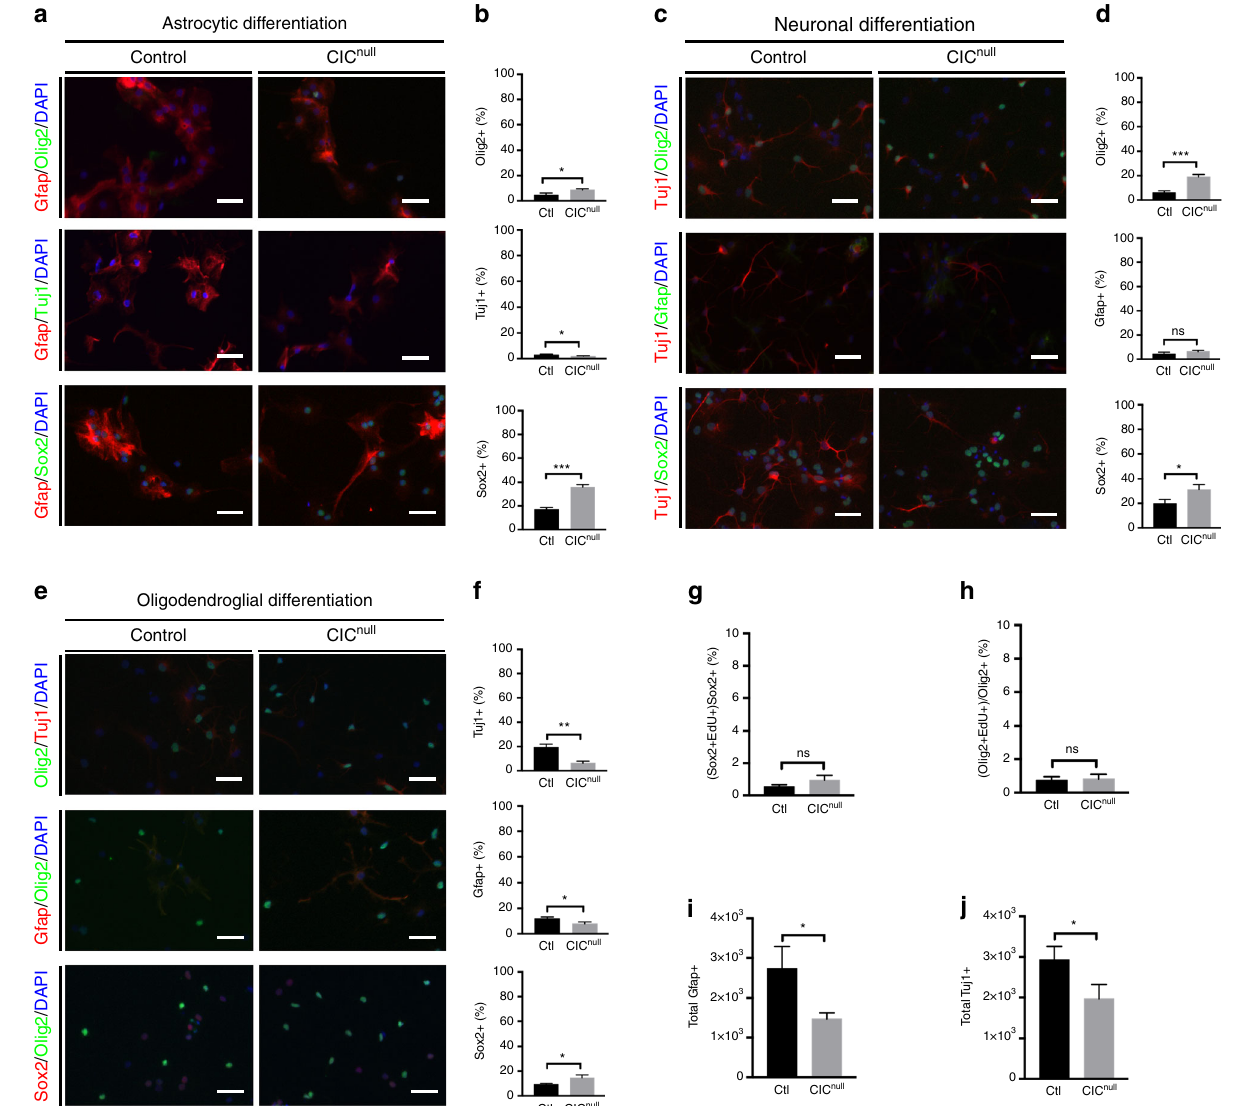
Fig. 6 Alternate lineage selection of Cic -null NSCs in response to extrinsic differentiation cues. a , b NSCs cultured for 10 days in astrocyte-promoting media and stained for Sox2, Olig2, GFAP, and Tuj1. Representative images of cultures stained for oligodendrocytes (Olig2 + ), neurons (Tuj1 + ) and stem cells (Sox2 + ) in a ; and corresponding quanti fi cations of Olig2 + cells, Tuj1 + cells, and Sox2 + cells as a percentage of total cell enumerated by DAPI nuclear counterstain b . c , d NSCs cultured for 10 days under neuronal-promoting conditions, with representative images c of cultures stained for oligodendrocytes (Olig2 + ), astrocytes (Gfap + ) and stem cells (Sox2 + ), and corresponding quanti fi cations d of Olig2 + cells, Gfap + cells, and Sox2 + cells as a percentage of total cells enumerated by DAPI. e , f NSCs cultured for 10 days under oligodendroglial-promoting conditions, with representative images e of cultures stained for neurons (Tuj1 + ), astrocytes (Gfap + ) and stem cells (Sox2 + ), and corresponding quanti fi cations d of Tuj1 + cells, Gfap + cells, and Sox2 + cells as a percentage of total cells enumerated by DAPI. g Percentage of Sox2 + cells positive for EdU incorporation after 10 days exposure to neuronal-promoting conditions. h Percentage of Olig2 + positive for EdU incorporation after 10 days exposure to neuronal-promoting conditions. i Absolute counts of Gfap + cells/well after differentiating 4 × 10 3 NSCs in astrocytic conditions for 10 days. j Absolute counts of Tuj1 + cells/well after differentiation 4 × 10 3 NSCs in neuronal conditions for 10 days. Data from n = 3 biologic replicates per condition for all experiments. Source data are provided as a Source Data fi le. Statistical analysis performed by unpaired t test. Bars indicate mean ± SD. Scale bar: 10 μ m. ns — not signi fi cant, * p < 0.05, *** p <